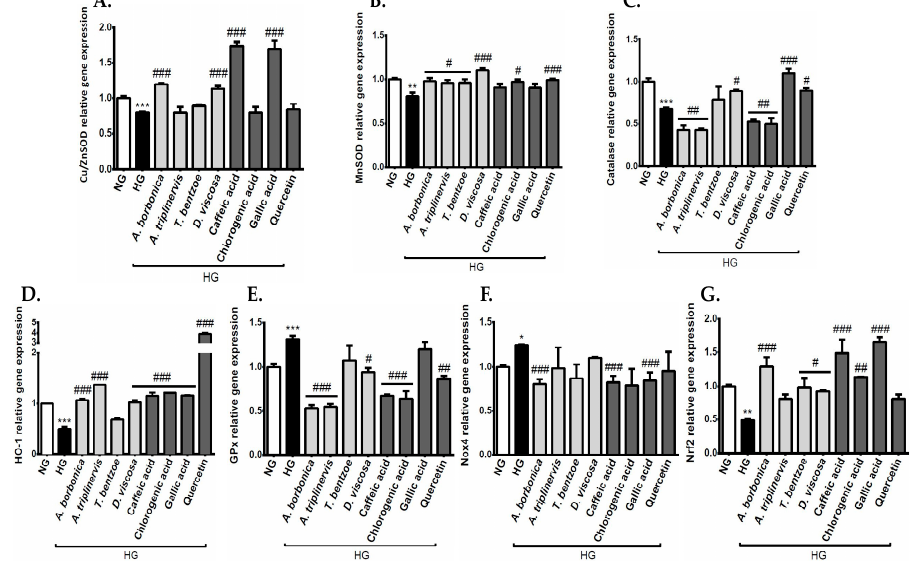
Figure 4. Effect of polyphenols on the expression of genes encoding redox enzymes and nuclear factor erythroid 2-related factor 2 (Nrf2) transcription factor on cerebral endothelial cells in hyperglycemic condition. Cells were exposed to normoglycemic condition (NG) or hyperglycemic condition (HG) in the presence or not of each polyphenol-rich plant extract (10 μ M GAE) or standard polyphenol (10 μ M). The expression of genes coding for Cu/ZnSOD ( A ), MnSOD ( B ), catalase ( C ), and heme oxygenase-1 (HO-1) ( D ), GPx ( E ), Nox4 ( F ), and Nrf-2 ( G ) was measured by RT-qPCR and normalized to GAPDH gene expression. The data are means ± SEM of three independent experiments. *: p < 0.05, **: p < 0.01 and ***: p < 0.005, as compared to NG. #: p < 0.05, ##: p < 0.01 and ###: p < 0.005 as compared to HG.